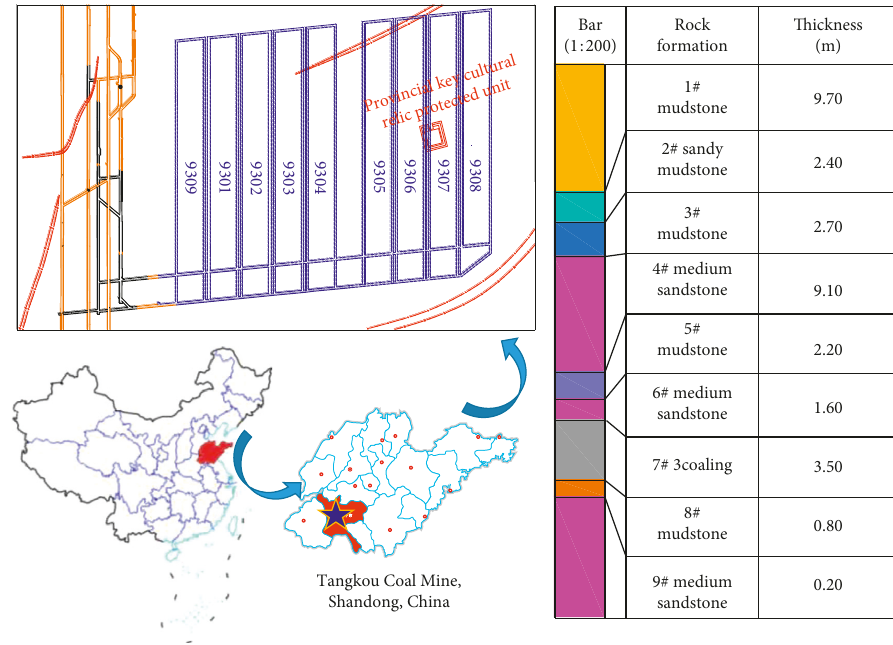
Figure 10: Location of Tangkou Coal Mine and layout of mining area.